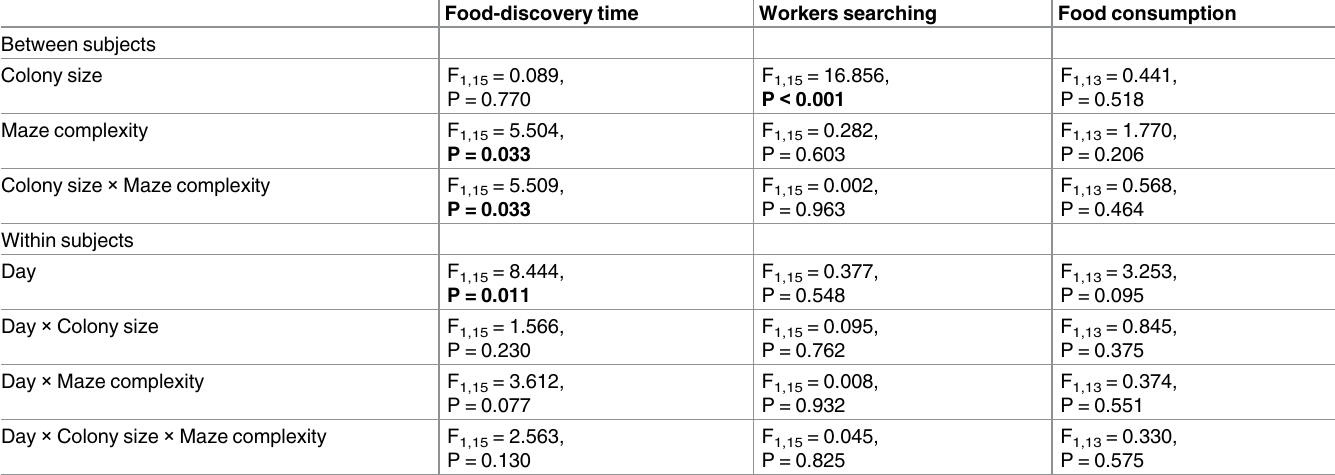
Table 2. The effectof colony size, mazecomplexityand day (1 vs. 2) on food-discoverytime, the number of workerssearching, and food consump- tion (N = 19 for food-discovery time and workers searching and 17 for food